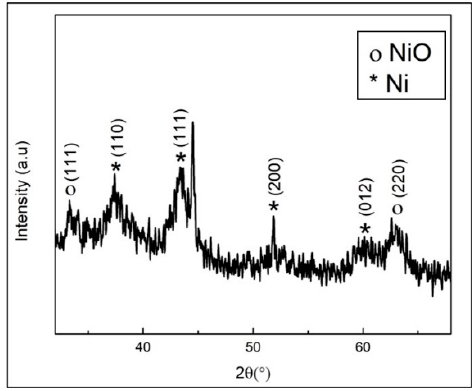
Figure 3. XRD pattern for Ni NPs.